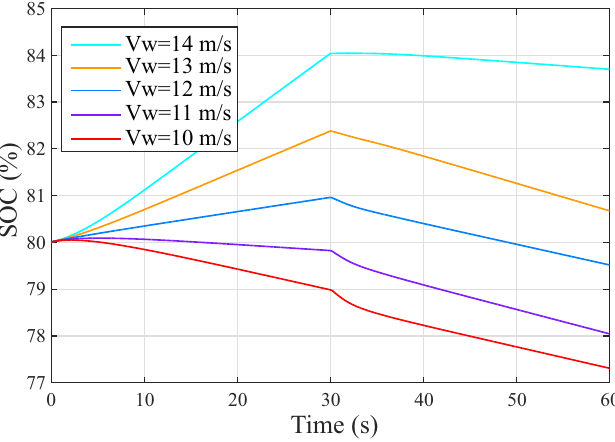
Figure 16. 80% initial battery SOC for all wind